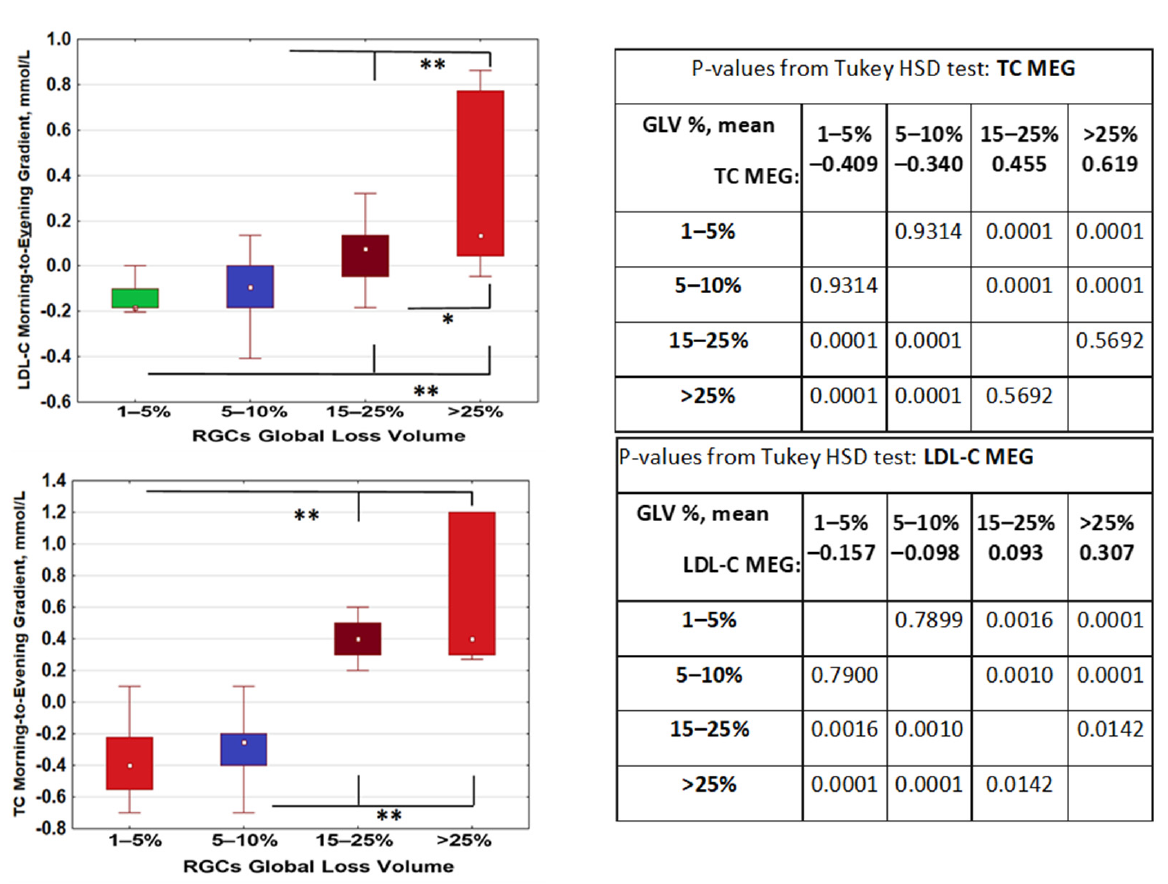
Figure 4. Morning–evening gradients (MEGs) of total cholesterol (TC, left) and low-density lipid cholesterol (LDL-C, right) depended on retinal ganglion cells global volume loss (GLV%). n = 114; RGC GLV < 5%, n = 16; GLV = 5–10%, n = 49, GLV = 15–25%, n = 35; n > 25%, n = 14). Note that MEG was decreasing in individuals with GLV% lower than 10% and changed sign to increasing in individ- uals with RGC GLV of 15% or more; LDL-C MEGs increased further in patients with GLV% above 25%. TC: KW-H (3;114) = 71.776; p < 0.0001; LDL-C: KW-H (3;114) = 41.933; p < 0.0001. GLV%: two-eye